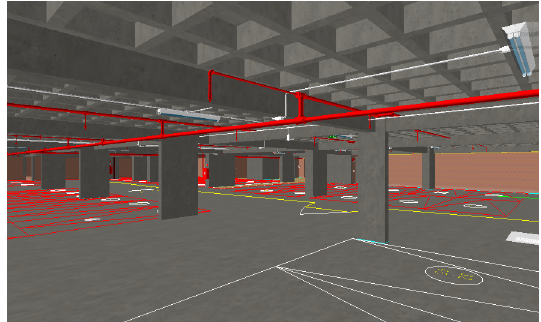
Figure 5: Omitted underground drainage.